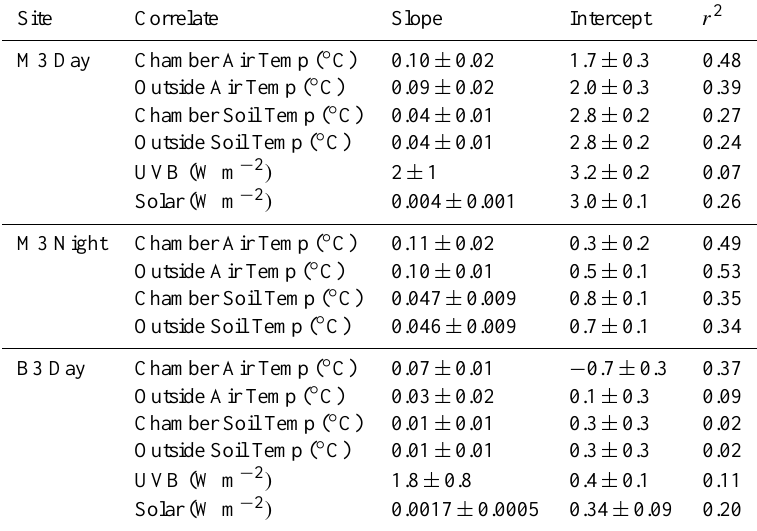
Fig. 4. Natural logarithms of GEM emission fluxes measured over sites M3 (blue) and B3 (red), compared to air temperature inside (a) and outside (b) the chamber; soil temperature inside (c) and outside (d) the chamber; and incident UVB (e) and solar (f) radiation. Circles represent measurements taken during the day (defined as net radiation > 20Wm − 2 ) whilst triangles represent measurements taken at night. Table 3. Linear correlation coefficients for relationships shown in Fig.